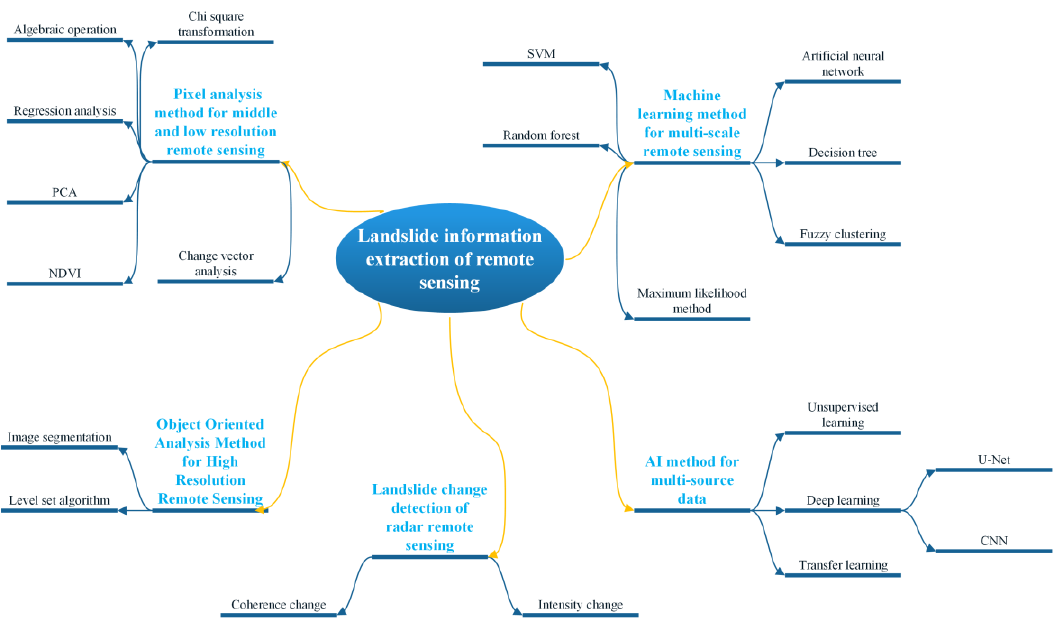
Figure 1. Summary of landslide remote sensing information extraction methods.